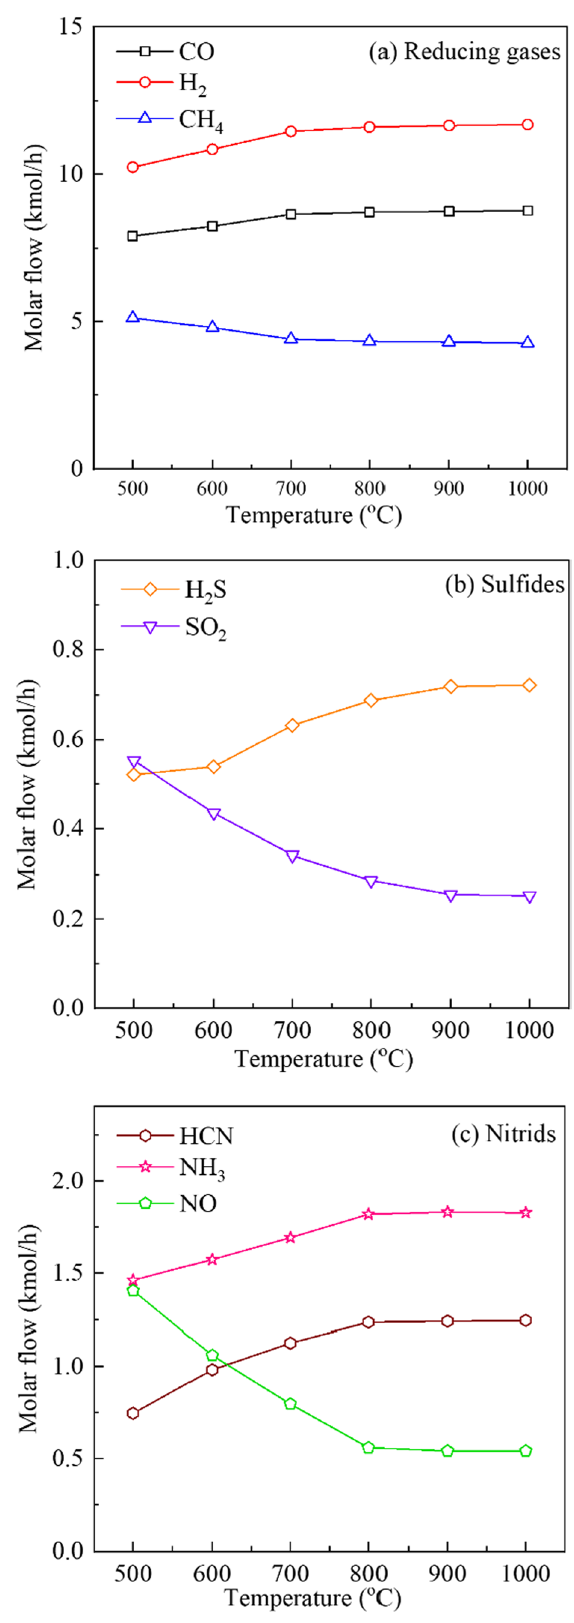
Fig. 5 Pyrolysis of materials at different